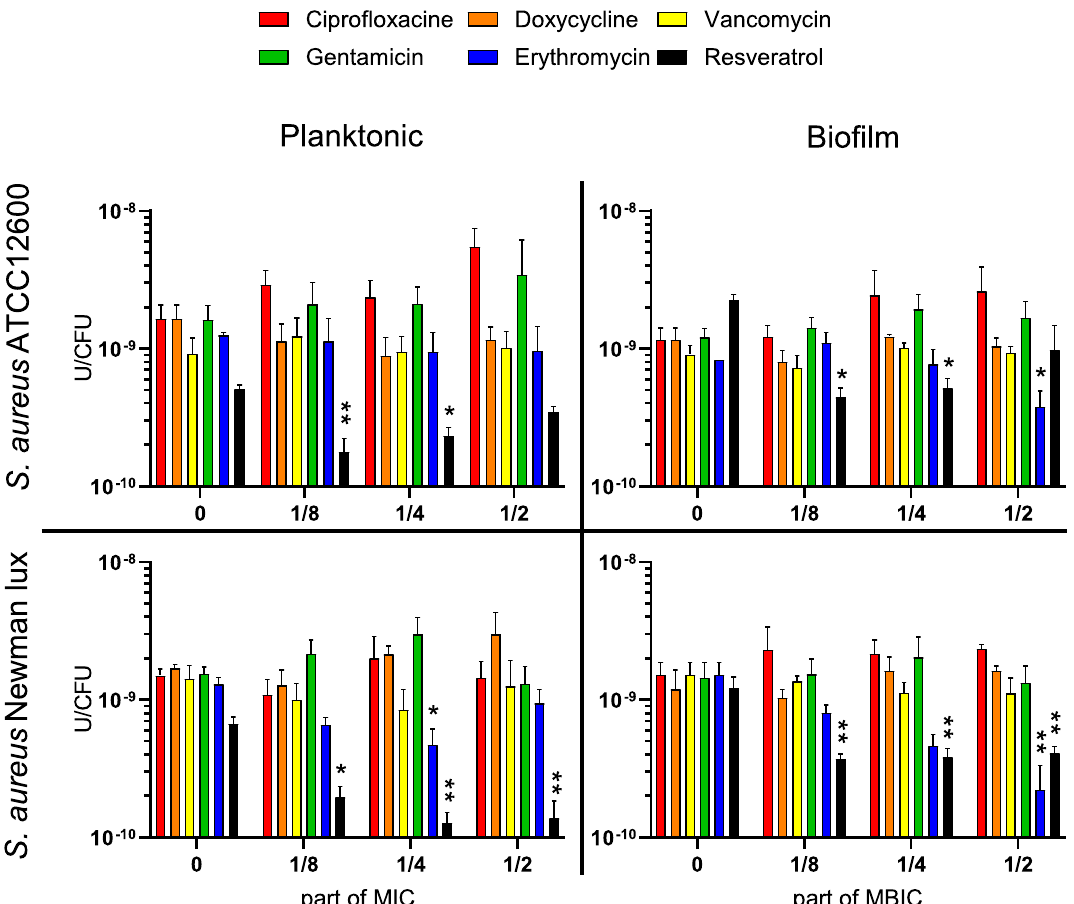
Figure 4. Micrococcal nuclease (MN) production per CFU of S. aureus ATCC12600 and Newman lux, growing planktonically and in biofilm under antibiotic pressure. Data shown are averages of triplicate measurements, repeated on separate days. Error bars indicate standard error of the mean. Statistical differences were calculated using an ANOVA comparing lognormal values with control values where antimicrobial concentration = 0). *Significant difference between value and the culture without antibiotics (*p < 0.05; **p <